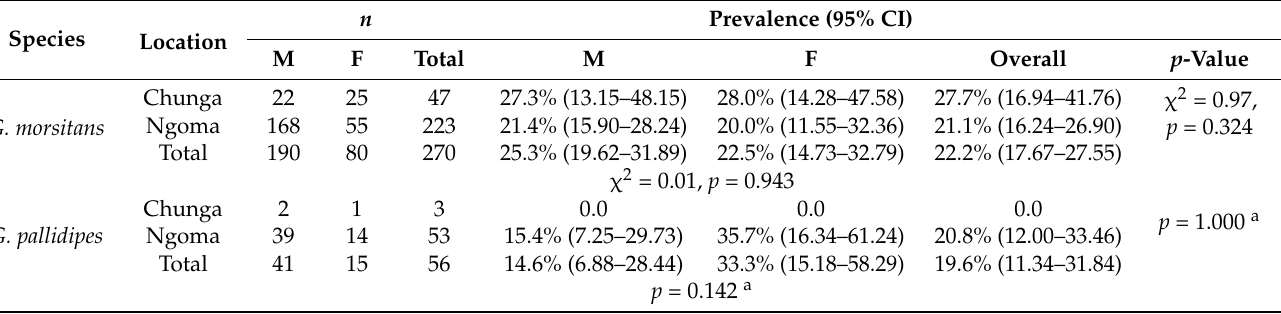
Table 5. Prevalence of S. glossinidius in G. morsitans and G. pallidipes based on sex and sampling site.